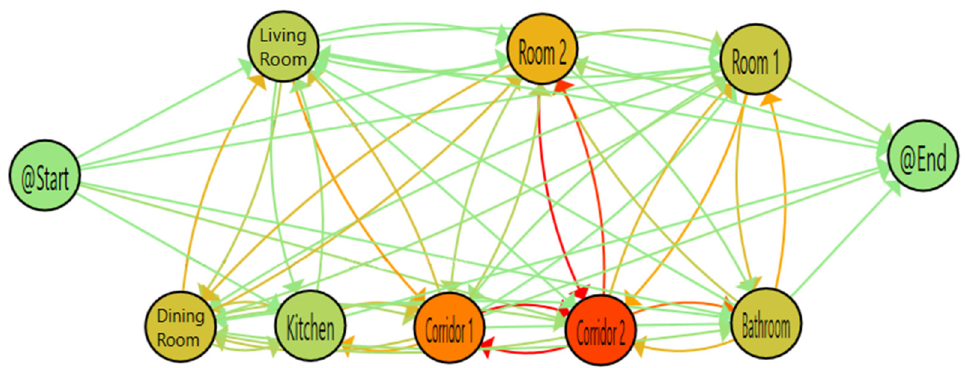
Figure 12. PALIA TPA for CASAS using additional sensors. Table 5. Confusion matrix of transitions for CASAS using extra sensors.